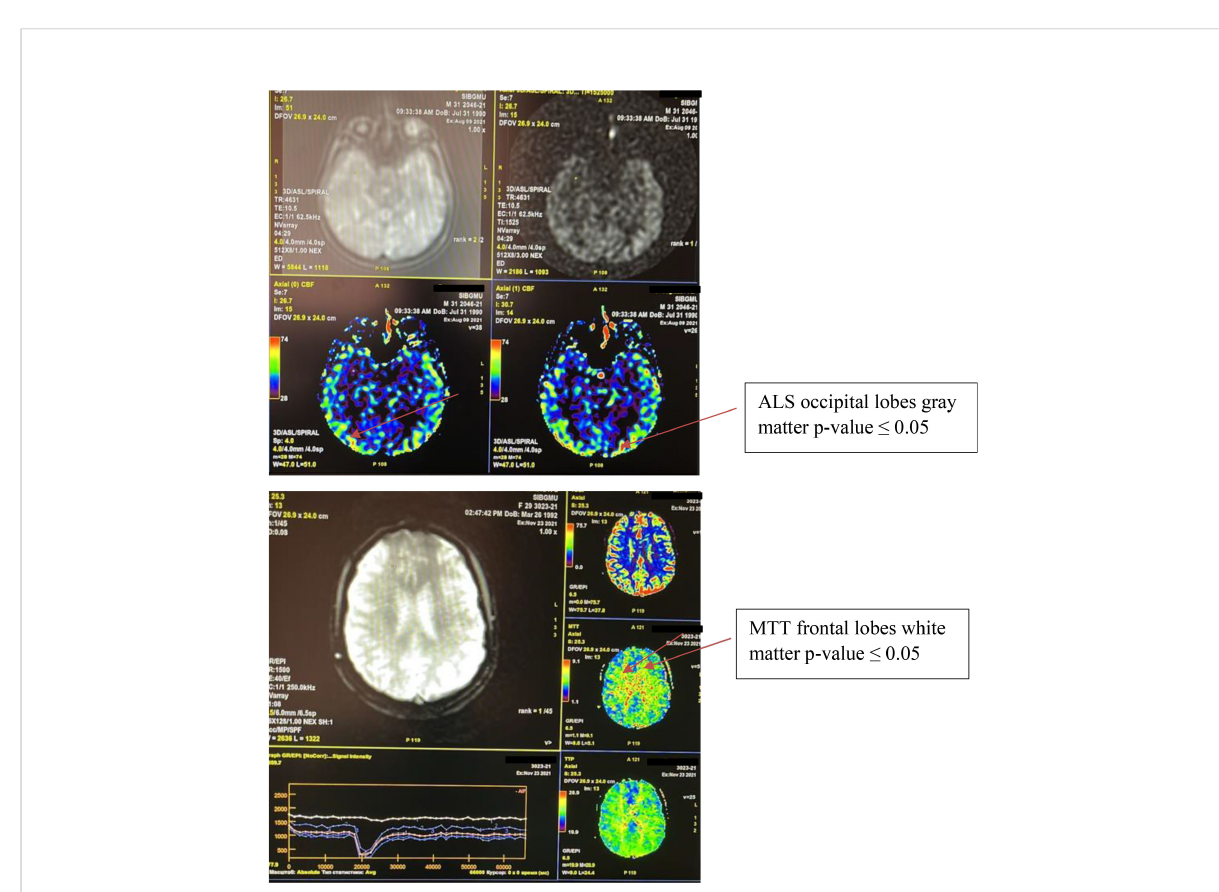
FIGURE 1 An image depicting an example of asymmetry perfusion in patent with diabetes type 1.